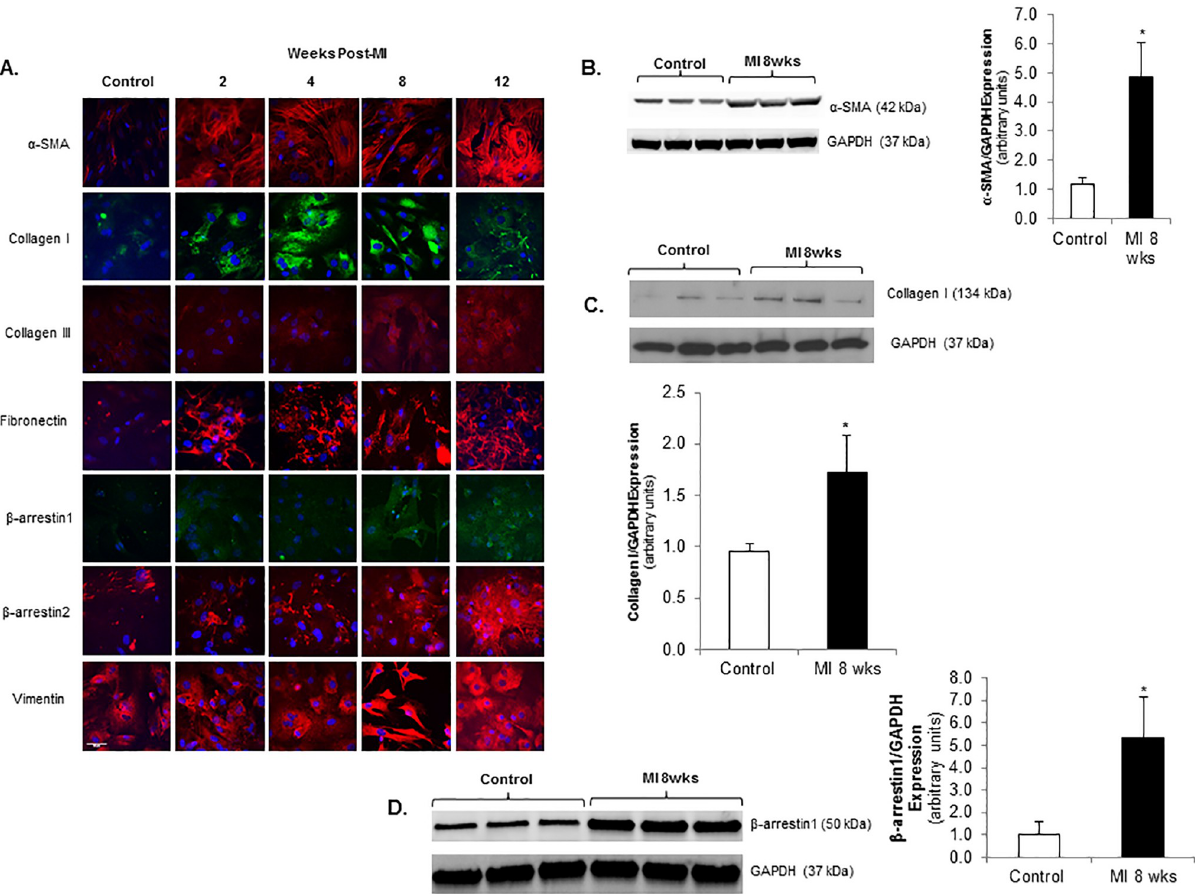
Fig 2. Cardiac fibroblasts undergo early transformation following myocardial infarction with upregulation of β -arrestin 1. A. Confocal images of α -SMA, collagen III, fibronectin, β -arrestin 1, β -arrestin 2 and vimentin stained red with Alexa Fluor 594 and collagen I stained green with FITC are shown in cardiac fibroblasts isolated from rat LV 2–12 weeks post-MI vs. normal control CF. Nuclei stained blue with DAPI. B. Representative immunoblots showing increased α -SMA expression in CF isolated 8 weeks post-MI vs. control. This membrane was stripped and re-probed with GAPDH. GAPDH used as loading control. Densitometric analysis showing increased CF α -SMA expression post-MI. � p < 0.025 vs. control; n = 4 in each group. C. Representative immunoblots showing increased collagen I expression in CF isolated 8 weeks post-MI vs. control. Membrane was cut based on the molecular weight and separately probed with Collagen I and GAPDH. GAPDH used as loading control. Densitometric analysis showing increased CF collagen I expression post-MI. � p < 0.025 vs. control; n = 4 in each group. D. Representative immunoblots ( upper panel ) showing increased β -arrestin 1 expression in CF isolated 8 weeks post-MI vs. control. This membrane was stripped and re-probed with GAPDH. GAPDH used as loading control. Densitometric analysis ( lower panel ) showing increased CF β -arrestin1 expression post-MI. � p < 0.035 vs. control; n = 4 in each group.